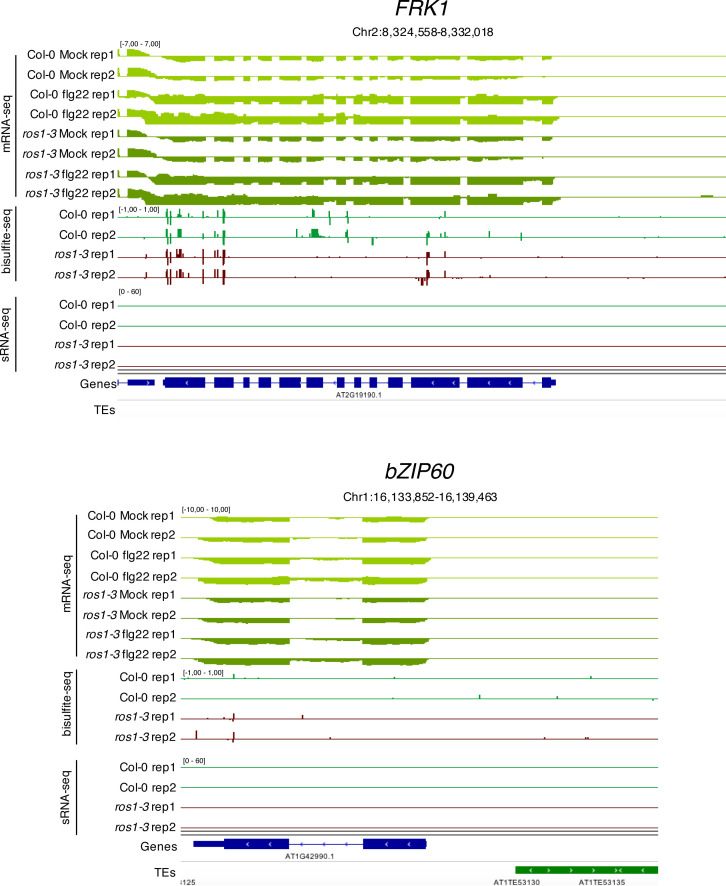
FRK1 and bZIP60 promoters are not hypermethylated in ros1-3 mutants.IGV snapshots showing mRNA levels (mRNA-seq) after syringe-infiltration of mock (water) or 1 μM of flg22 peptide in 5-week-old rosette leaves of Col-0 and ros1-3, and cytosine methylation levels (Bs-Seq) and siRNA levels (sRNA-seq) in 5-week-old untreated rosette leaves of Col-0 and ros1-3, at the Flg22-induced Receptor-like Kinase 1 (FRK1) (upper panel) and bZIP60 (lower panel) loci.